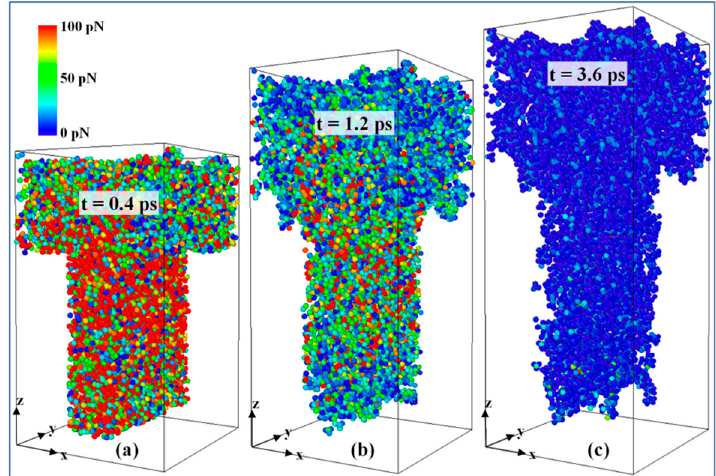
Figure 9. Demolding force per atom in 3:1 nanostructure at a simulation time of ( a ) 0.4 ps, ( b ) 1.2 ps, and ( c ) 3.6 ps.